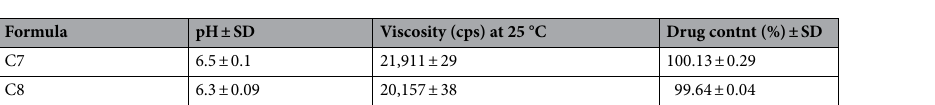
Table 5. Results of appearance and physical parameters of CLN-free base